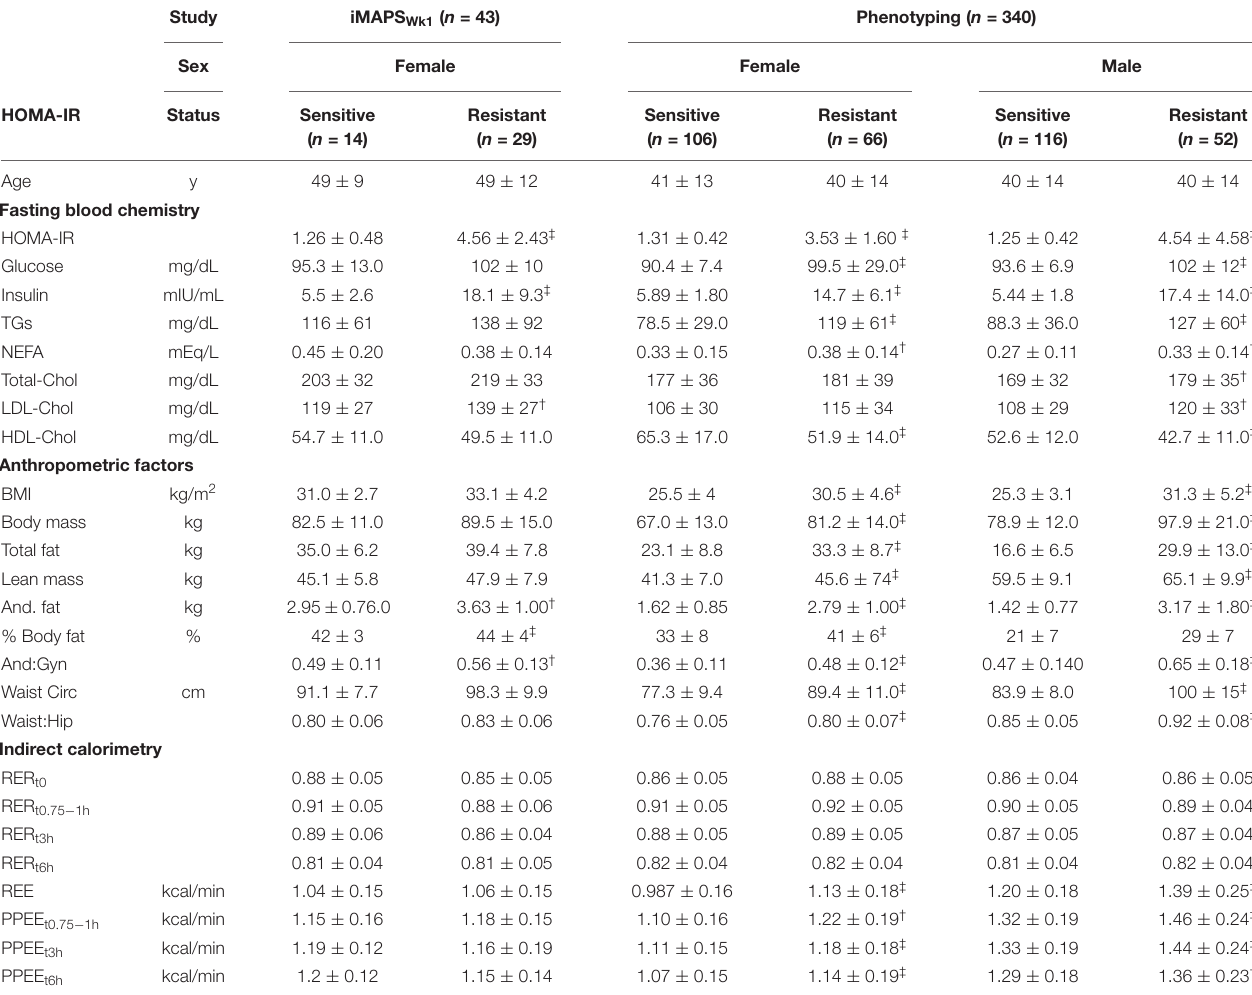
TABLE 2 | Participant population baseline blood chemistry, body composition, and metabolic